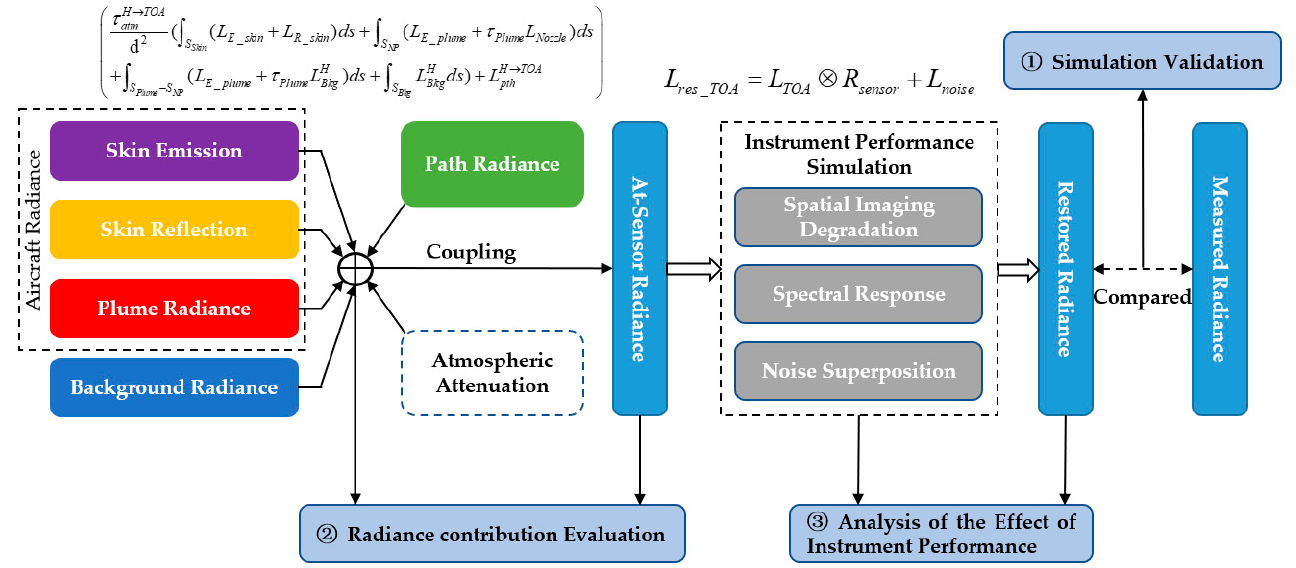
Figure 2. The flow chart of evaluation and analysis in this study.